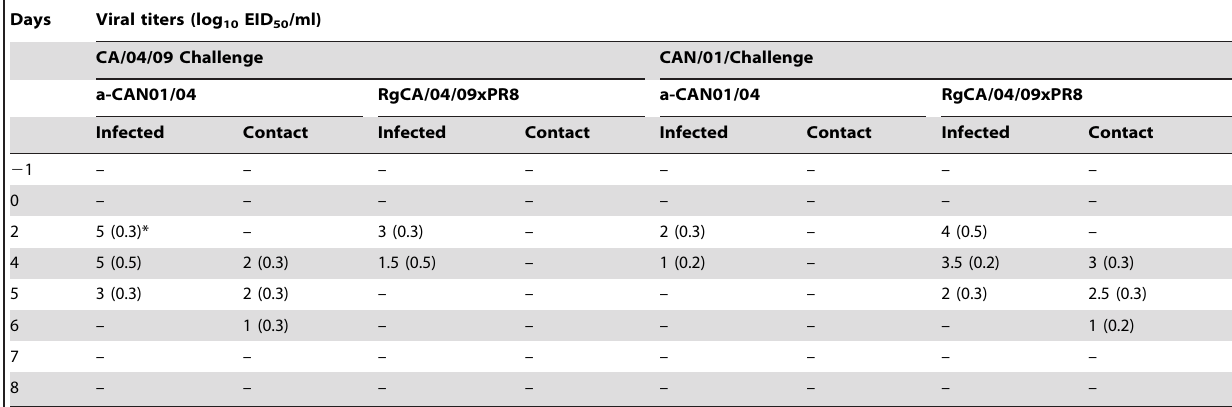
Table 4. Nasal excretion of CA/04/09 and CAN01/04 in double-vaccinated mini-pigs.